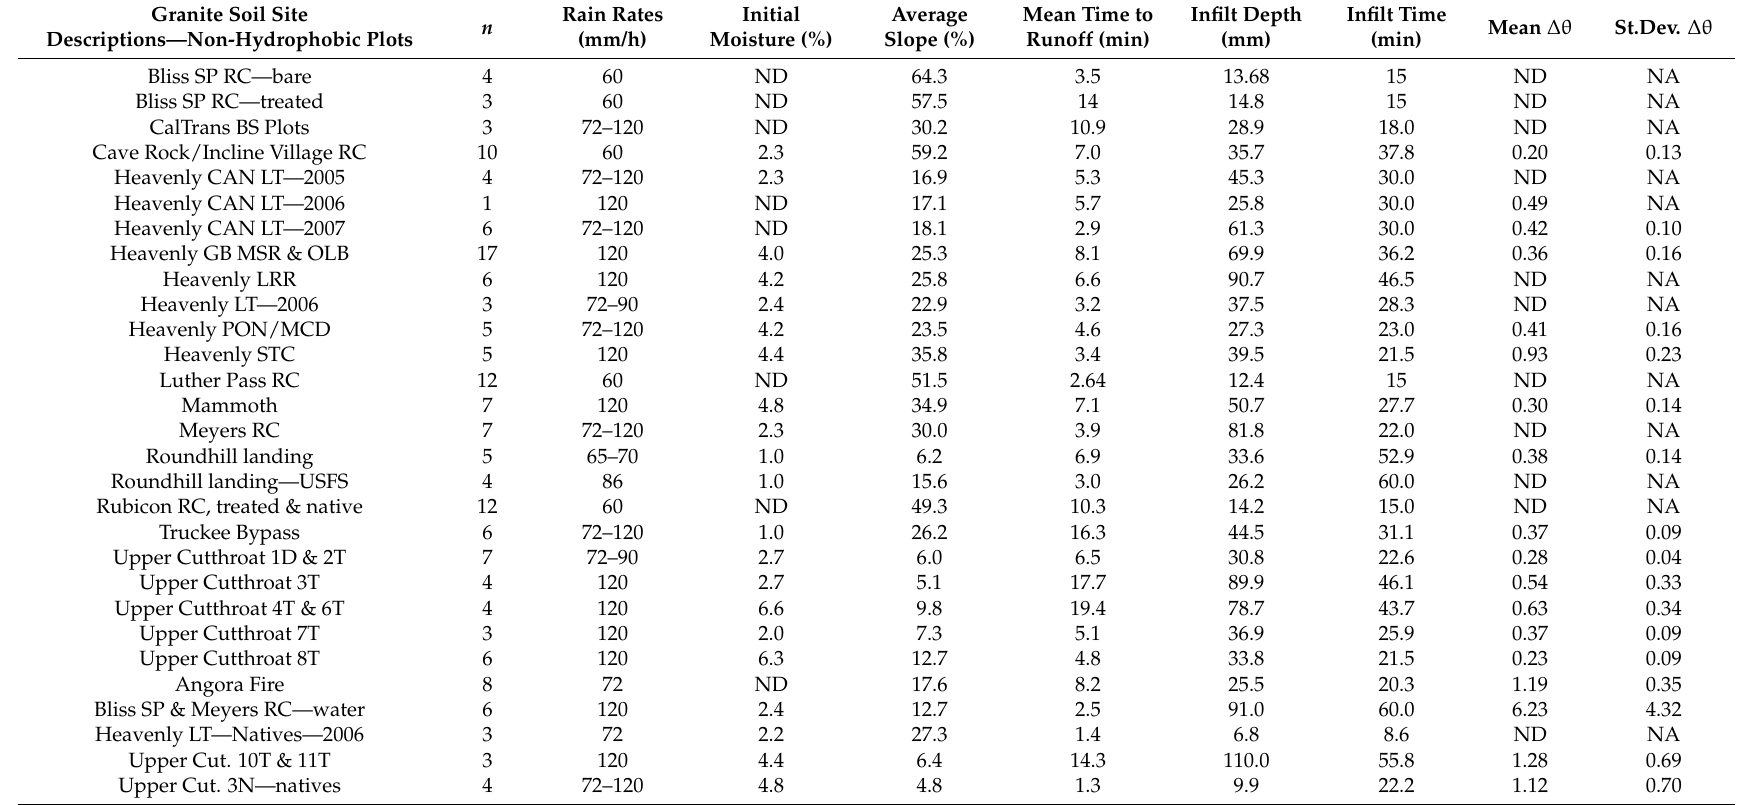
Table 4. Summary of RS plot setting data averages for granitic soil plots generating